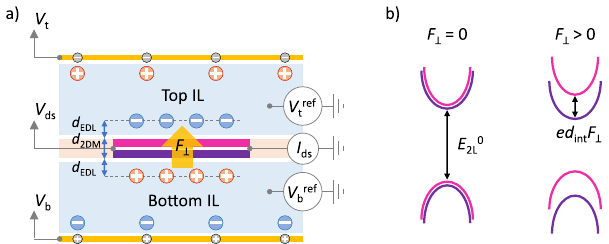
Fig.1|Dualionicliquidgating.a Conceptofadualionicliquid-gatedbilayer2DM device. The potentials of the top ( V t ref ) and bottom ( V b ref ) ionic liquids (ILs) are independently controlled by the top ( V t ) and bottom ( V b ) gate voltages. The potential difference between top and bottom ILs drops over a ~2nm thick layer consistingoftwoelectricaldoublelayers(thickness d EDL )andthebilayer(thickness fi eld ( F ⊥ ) through the bilayer. The d 2DM ), thereby generating an intense electric drain-source voltage ( V ds ) controls a drain-source current ( I ds ) through the 2DM. b Abandstructuresketchofabilayer2DMatzeroandnon-zeroelectric fi eld.When no fi eld is applied through the bilayer, the bandgap is E 2L 0 . The fi eld breaks the degeneracy between the energy bands corresponding to opposite layers and reduces the overall bandgap by ed int F ⊥ , where d int is the 2DM interlayer distance and e is the elementary